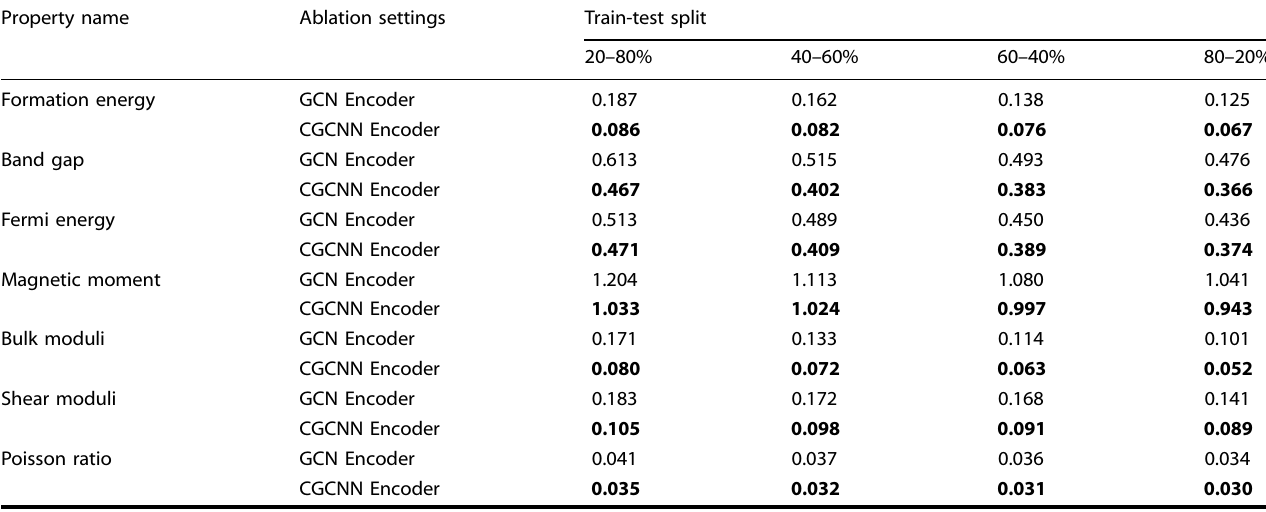
Table 7. Summary of experiments (MAE) of ablation study on the effect of GCN as graph encoder in CrysAE and CrysXPP.